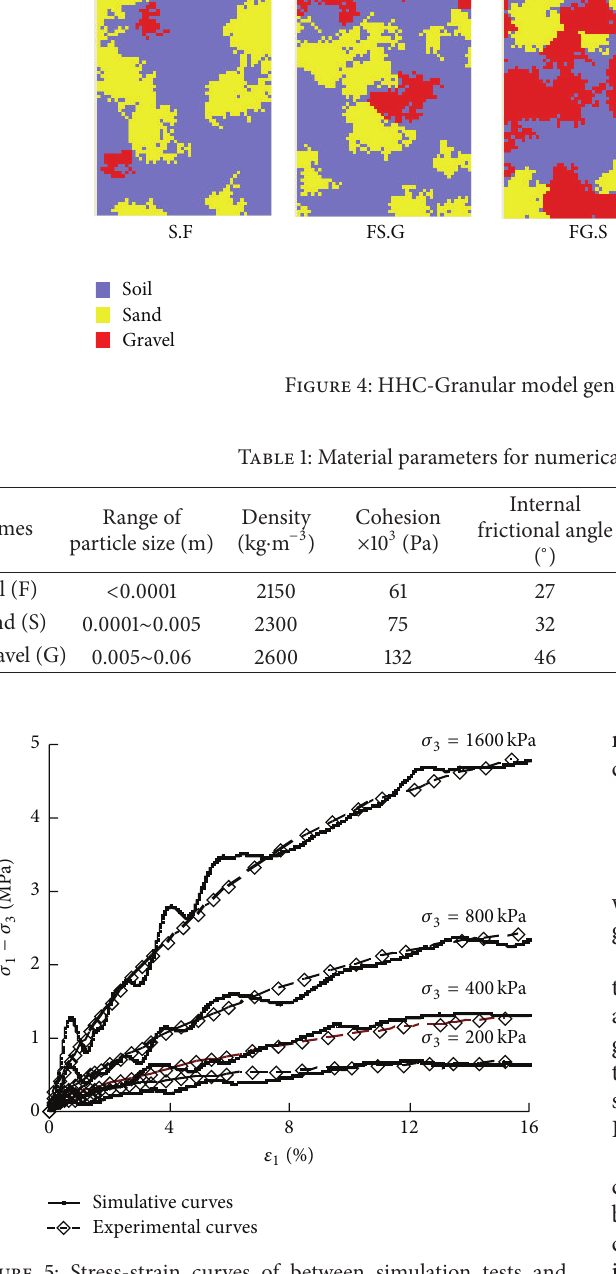
Figure 5: Stress-strain curves of between simulation tests and indoor